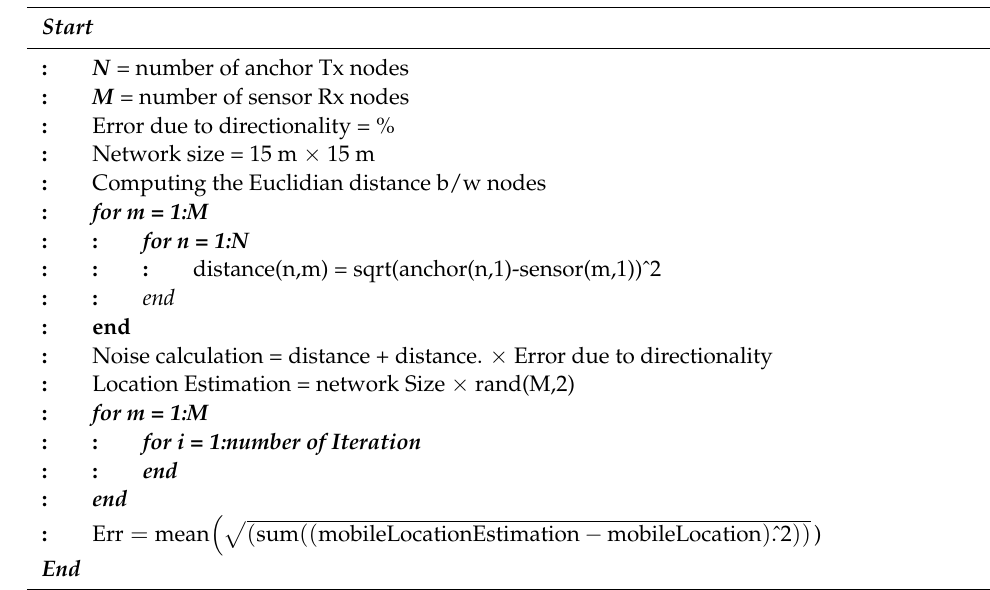
Algorithm 1: A Pseudo Code of the Proposed